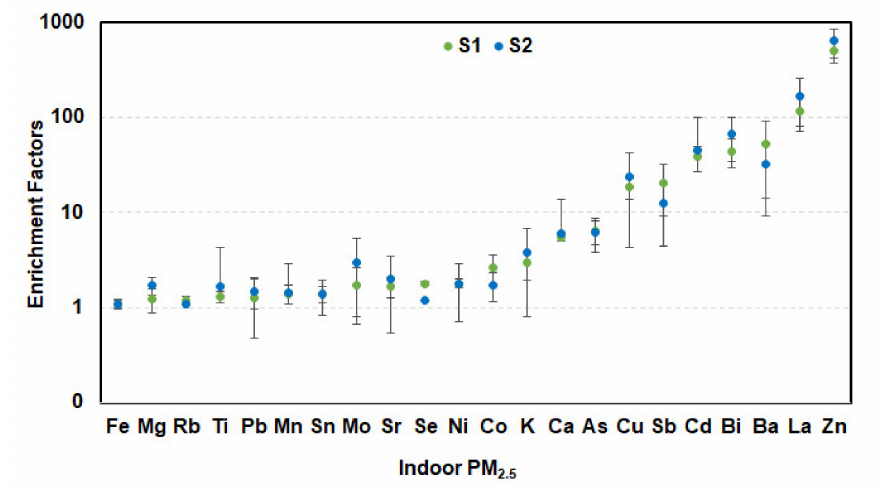
Figure 10. Enrichment factors of elements in indoor PM 2.5 collected during the class at S1 and S2 (n = 10, average ±